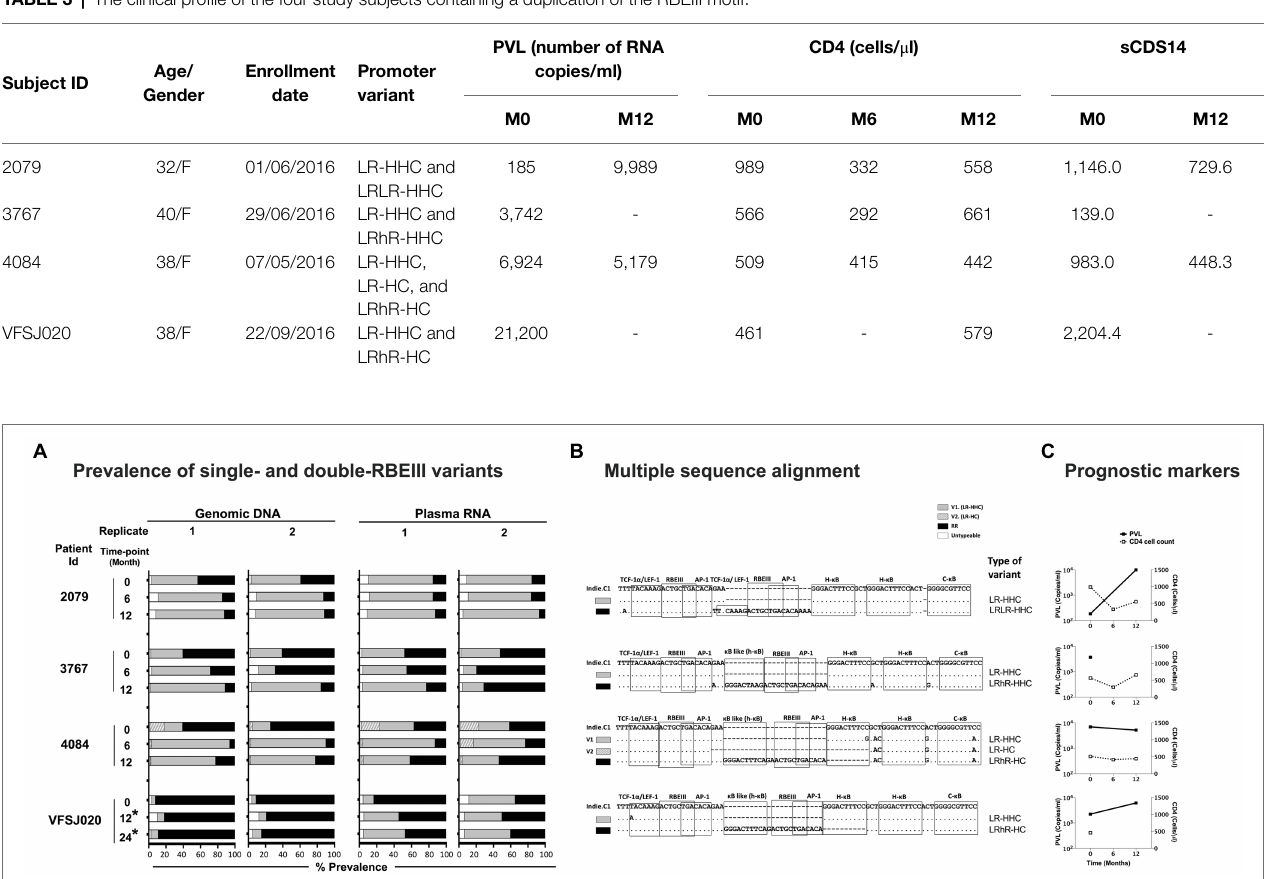
FIGURE 5 | The frequencies of single- and double-RBEIII variants in a subset of study participants. (A) Two independent analyses were performed (replicates 1 and 2) using both the whole blood genomic DNA and plasma viral RNA. The samples were collected at six-month intervals, as shown. An asterisk (*) represents the samples collected post-ART. The dark, grey, and hollow bars represent the percentage prevalence of double-RBEIII, single-RBEIII, and minority/un-typable viral strains, respectively. (B) Multiple sequence alignment of single- and double-RBEIII promoter variants in respective subjects, as indicated. TFBS of relevance are marked using open square boxes. The viral variants are aligned with the Indie.C1 reference sequence, which was pulsed in the sequencing sample as an internal control. Dashes and dots represent sequence deletion and sequence homology, respectively. (C) Prognostic markers, plasma viral load (PVL), and CD4 cell count are represented by a filled box with a solid line and an open box with a dotted line,